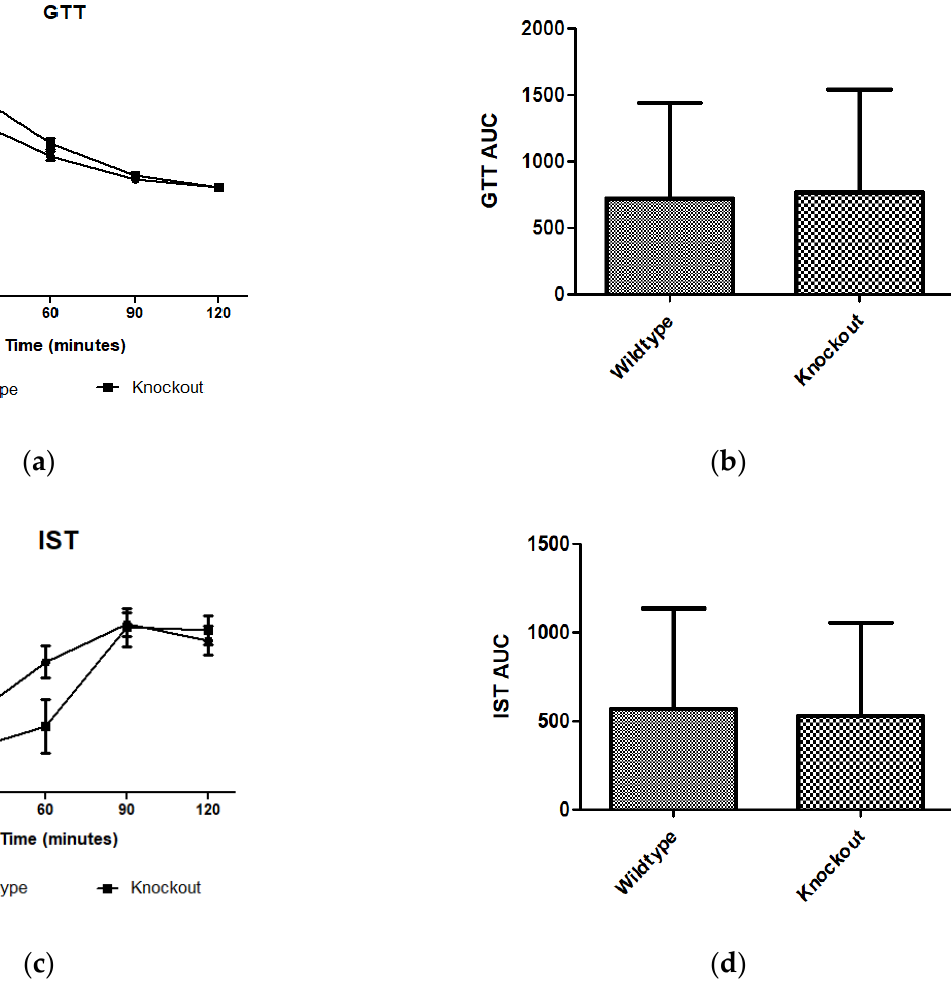
Figure 2. Effect of genotype on glucose tolerance and insulin sensitivity tests. GTT and IST were conducted before introducing the C57BL/6J wildtype and Slc7a8 knockout mice to CD or HFD. ( a , c ) No significant differences were observed in GTT or IST between the WT and KO mice except for significantly higher glucose levels ( p < 0.01) observed for the KO mice at 30 min with the GTT. ( b , d ) No significant differences were observed between the areas under the curve (AUCs) for WT and KO mice during GTT and IST. GTT: N = 47 for WT and N = 48 for KO; IST: N = 47 for WT and N = 44 for KO. ** p < 0.01.